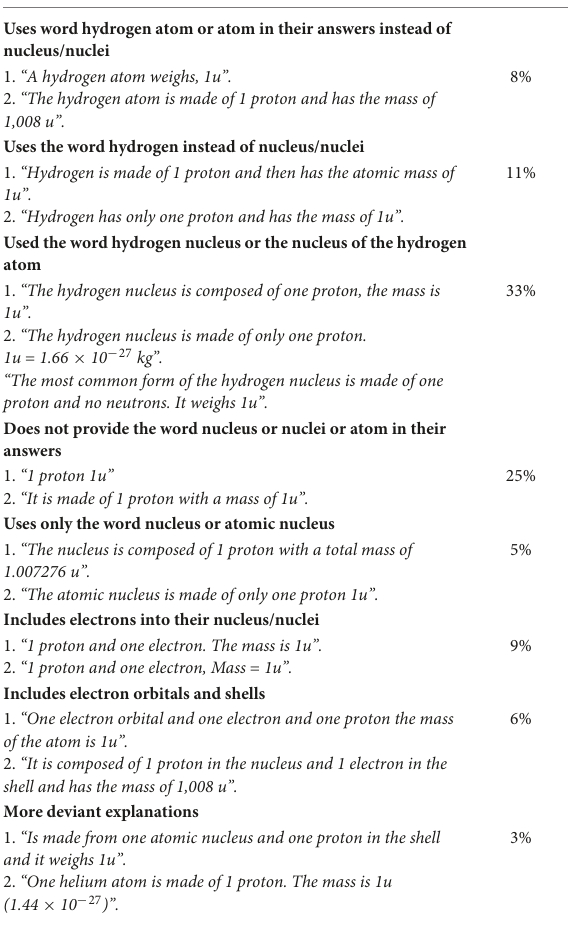
TABLE 1 A summary and categorization of all students written explanations regarding the hydrogen